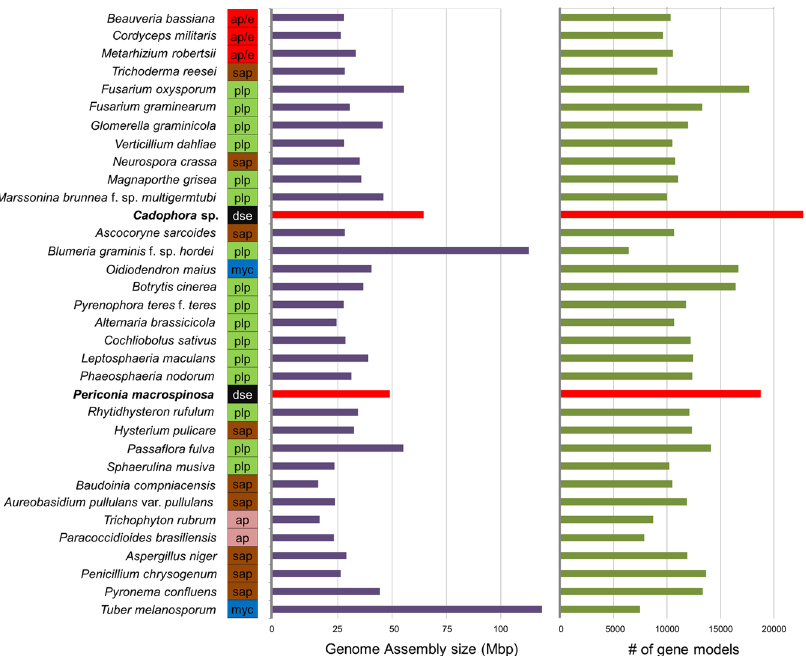
Figure 2. Genome size and number of predicted genes of Cadophora sp. and Periconia macrospinosa as compared with other ascomycetes. DSEs are labeled with bold names and red bars. After each species name, its type of lifestyle is indicated as follows: red (ap/e; animal pathogens/endophytes?), brown (sap; saprotrophs), green (plp; plant pathogens), black (dse, dark septate endophytes), blue (myc; mycorrhizal fungi), or pink (ap; animal pathogen). For complete species names and further information see Supplementary Table